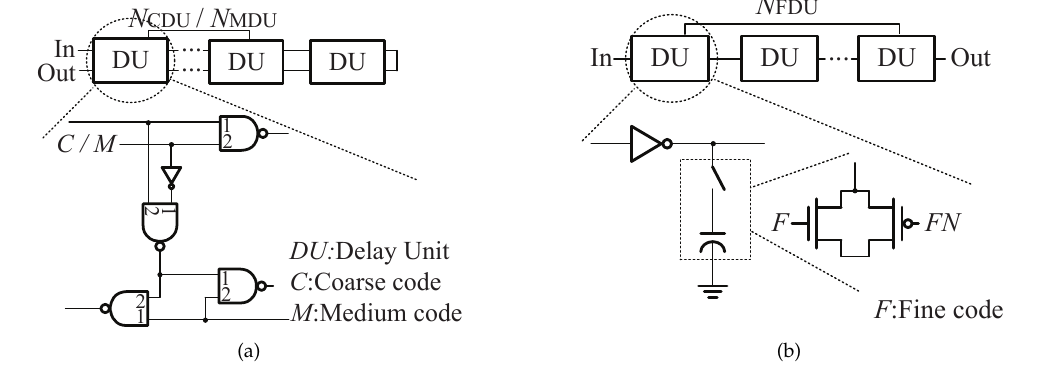
Figure 7. The structure and delay unit of sub-lines. ( a ) CDL and MDL; ( b )